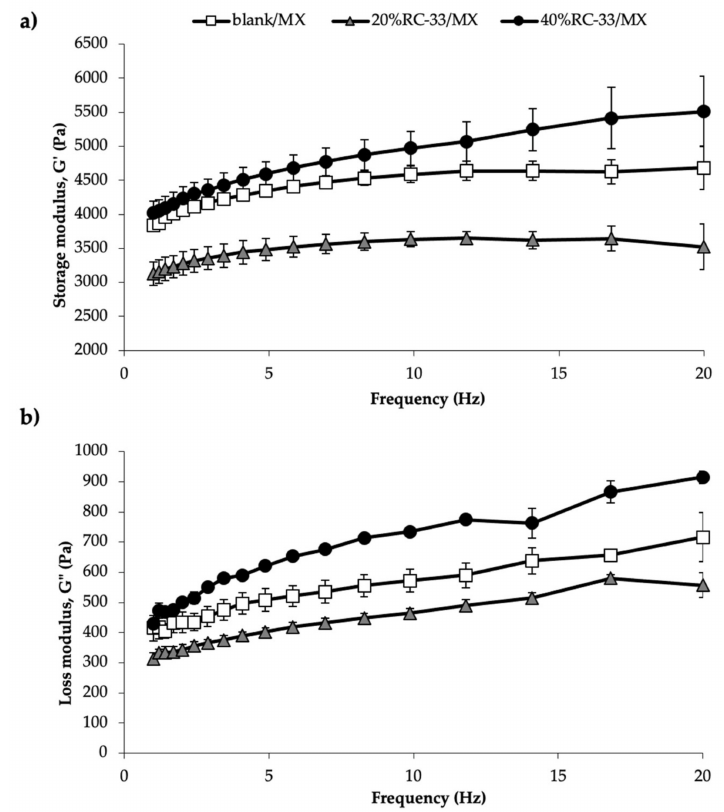
Figure 9. Storage (G’) ( a ) and loss (G”) ( b ) modulus vs. frequency profiles of matrices free of RC-33 (blank/MX) and loaded with RC-33 amounts corresponding to 20% and 40% of the GG interaction sites (respectively, 20%RC-33/MX and 40%RC-33/MX) upon 6 h hydration in pH 7.4 PBS; blank/MX was used as reference (mean values ± s.e.; n = 3).